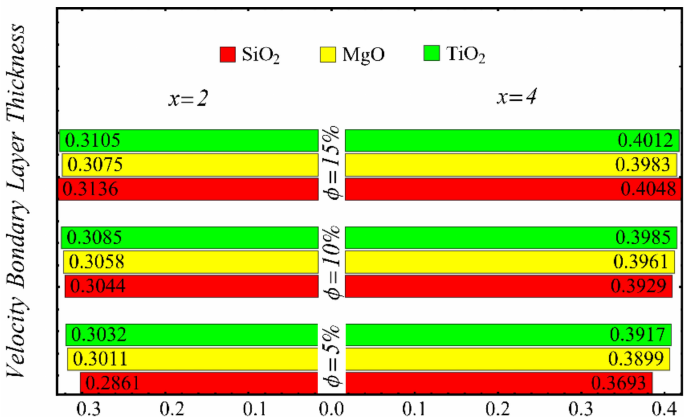
Figure 19. Velocity boundary-layer thickness at different nanoparticle concentrations.